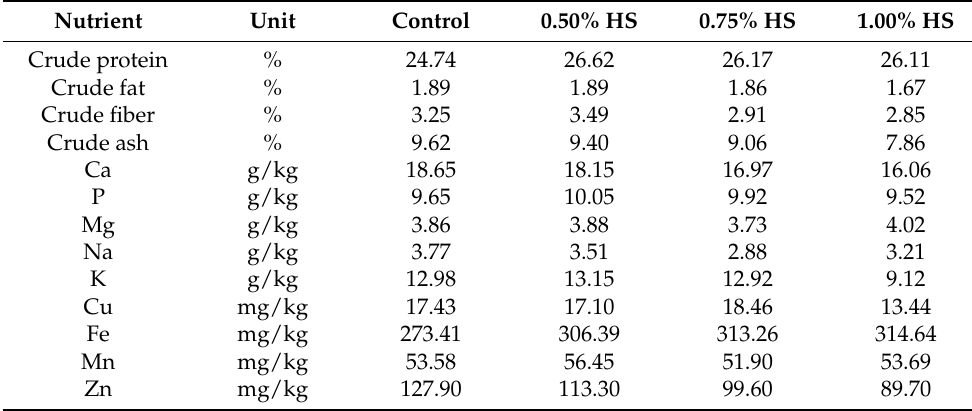
Table 2. Nutrient composition of diet: